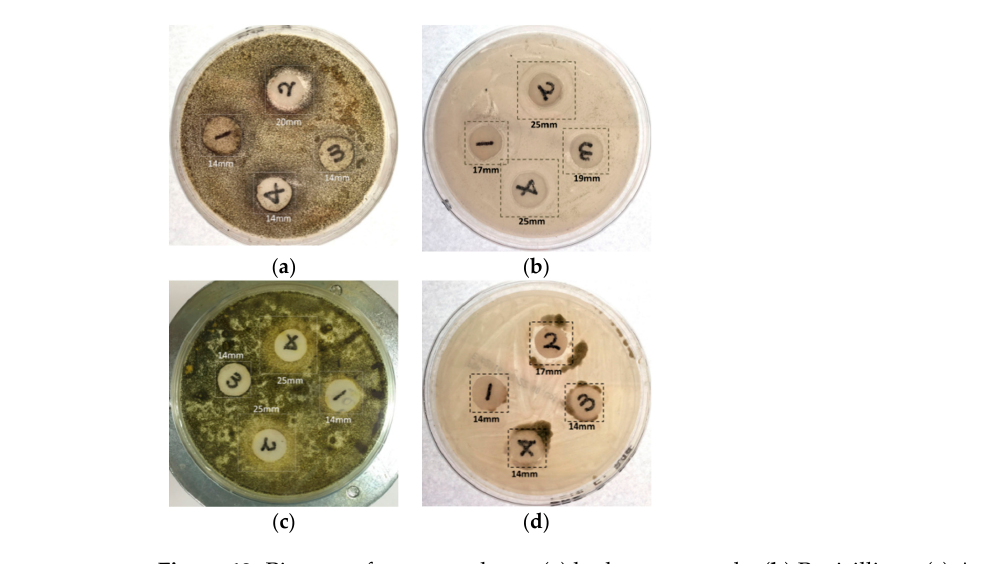
Figure 12. Pictures of cotton pad test: ( a ) bathroom sample; ( b ) Penicillium; ( c ) Aspergillus Niger; ( d ) Aspergillus Flavus.